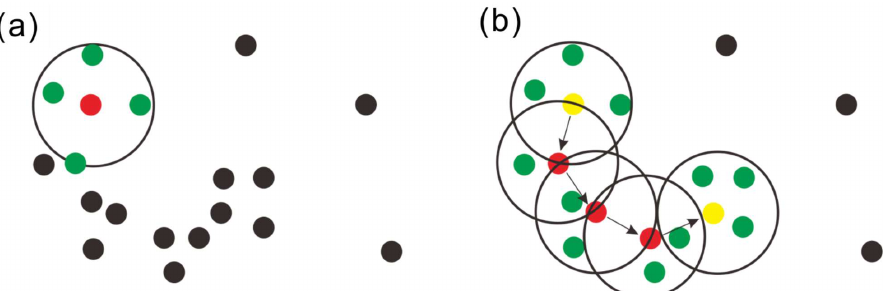
Figure 7. Key definition of DBSCAN. ( a ) Points (green dots) in the ε-neighborhood (circles) are density-reachable from core points (red dot); ( b ) density-connectivity (yellow dots). Adapted with permission from ref. [48]. Copyright 2012 Copyright Cui.